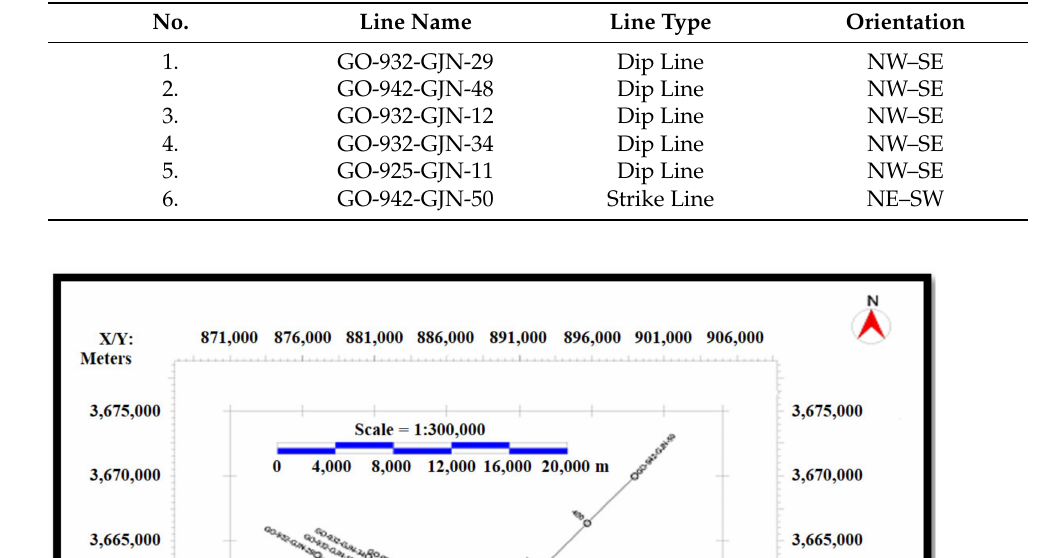
Table 2. Seismic lines available for interpretation of the Rajian area.